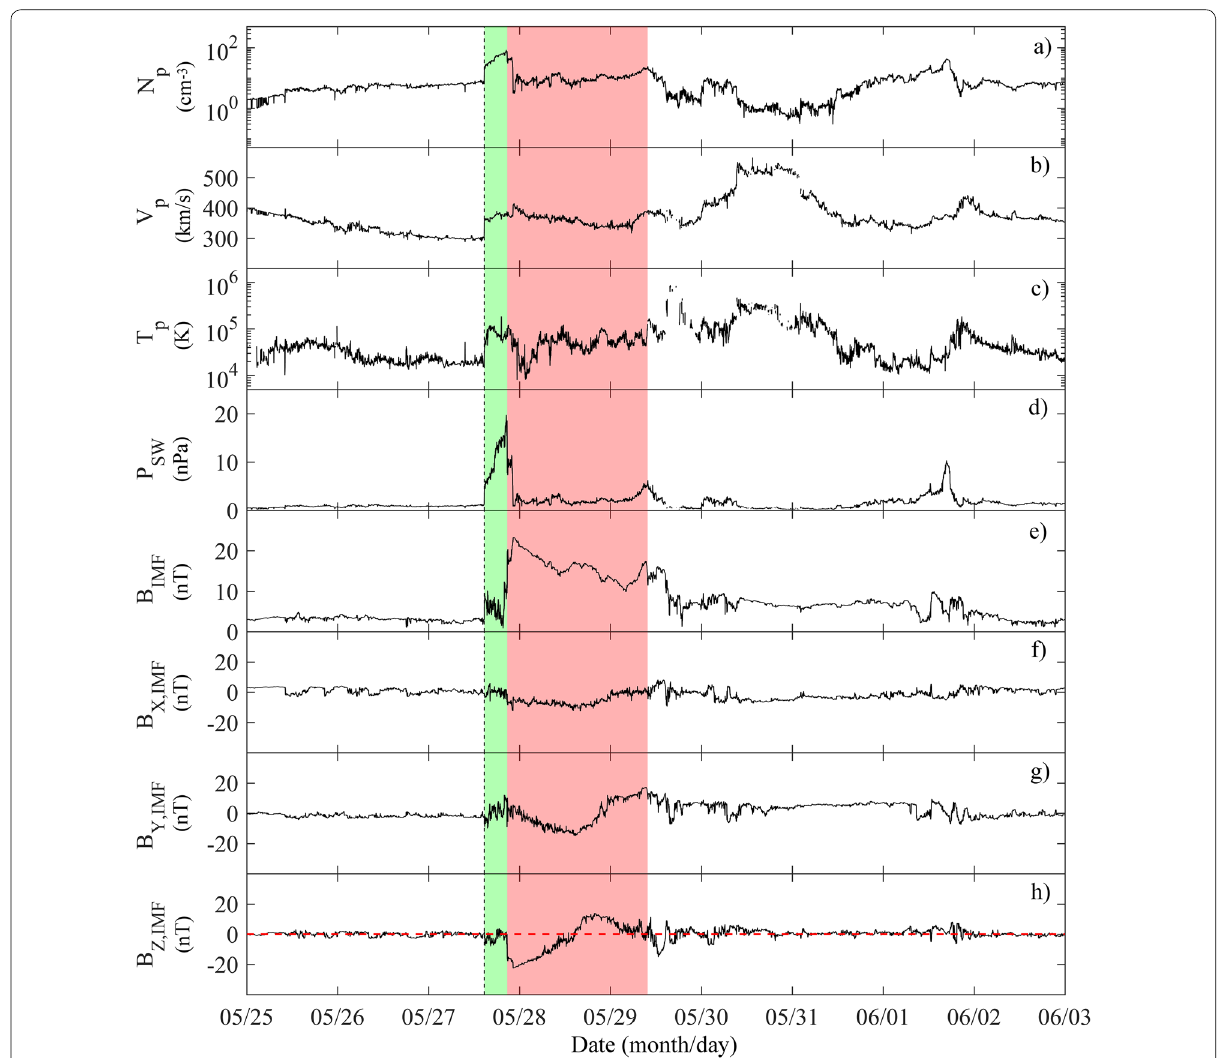
Fig. 3 Solar wind parameters between 25 May and 2 June 2017 observed by WIND (at first Lagrangian point), in UT: a proton density, b proton velocity, c proton temperature, d pressure, e IMF intensity, f – h IMF x , y , z components in the GSE coordinate system. The vertical black dashed line indicates the arrival of the interplanetary shock, on 27 May 2017 at 14:41 UT. The green area beyond is the ICME sheath, while the red area corresponds to the magnetic cloud (ejecta